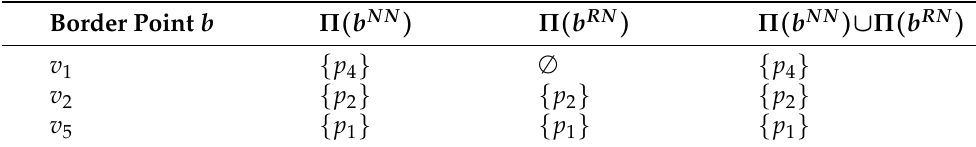
Table 3. Computation of the SP queries at the border